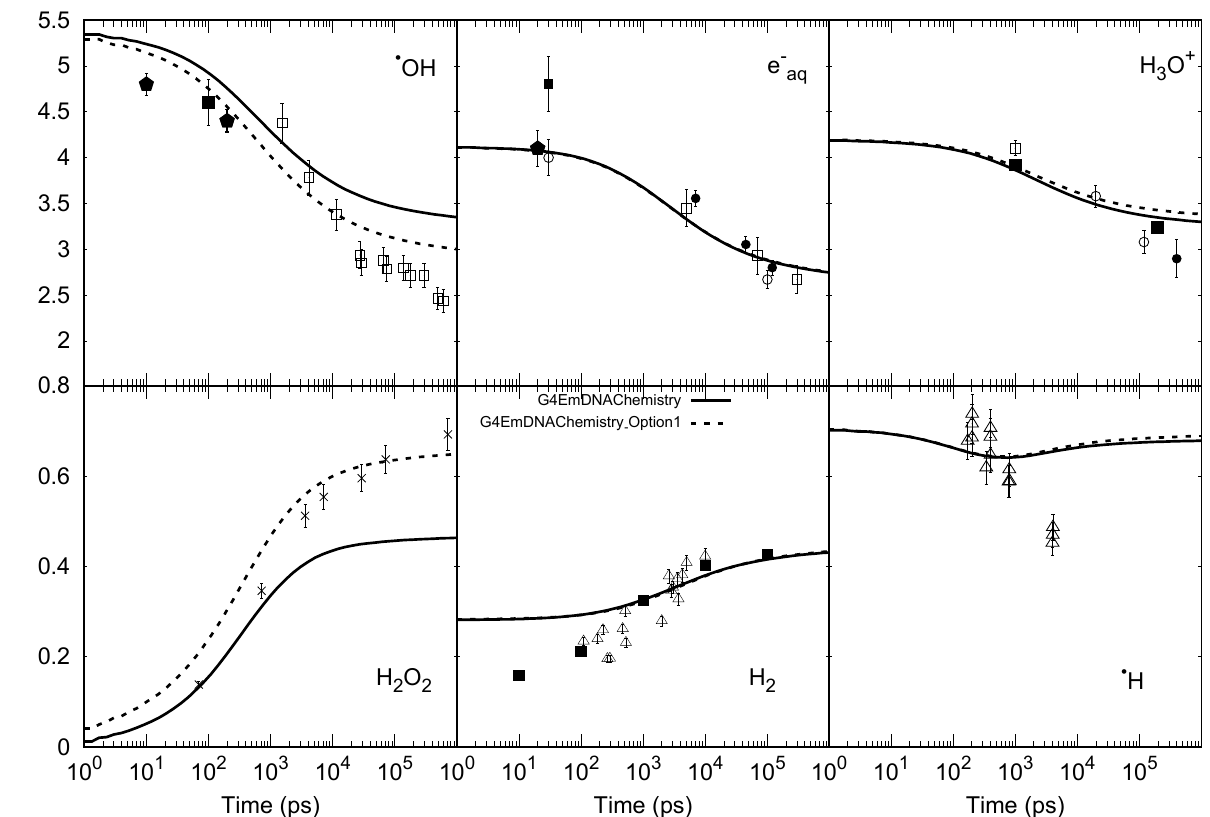
Figure 2. The G-values as a function of time calculated using the two chemistry constructors “G4EmDNAChemistry” and “ G4EmDNAChemistry_option1” of Geant4-DNA, and experimental data: OH ● : Laverne, 2000 [85], ■ Jay-Gerin et al., 2000 [86], El Omar et al., 2011 [87]; e − aq : Shi-